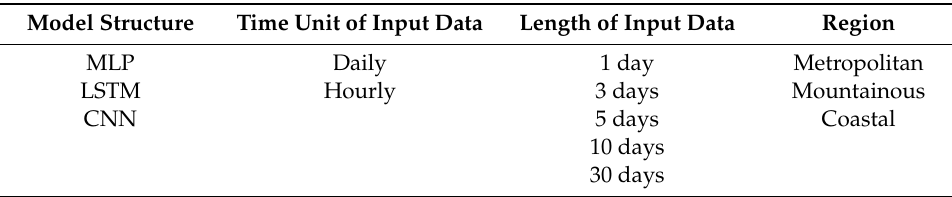
Table 14. Criteria of